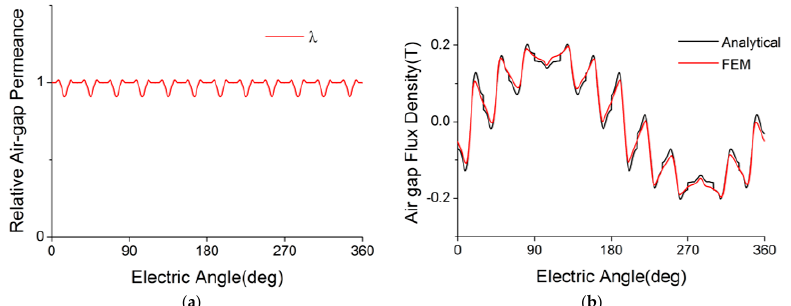
Figure 4. The complex relative air-gap permeance and the flux density in the middle of the air gap of the 12-pole SPM machine ( a ) Real component of the complex relative air-gap permeance; ( b ) Radial component of the flux density.